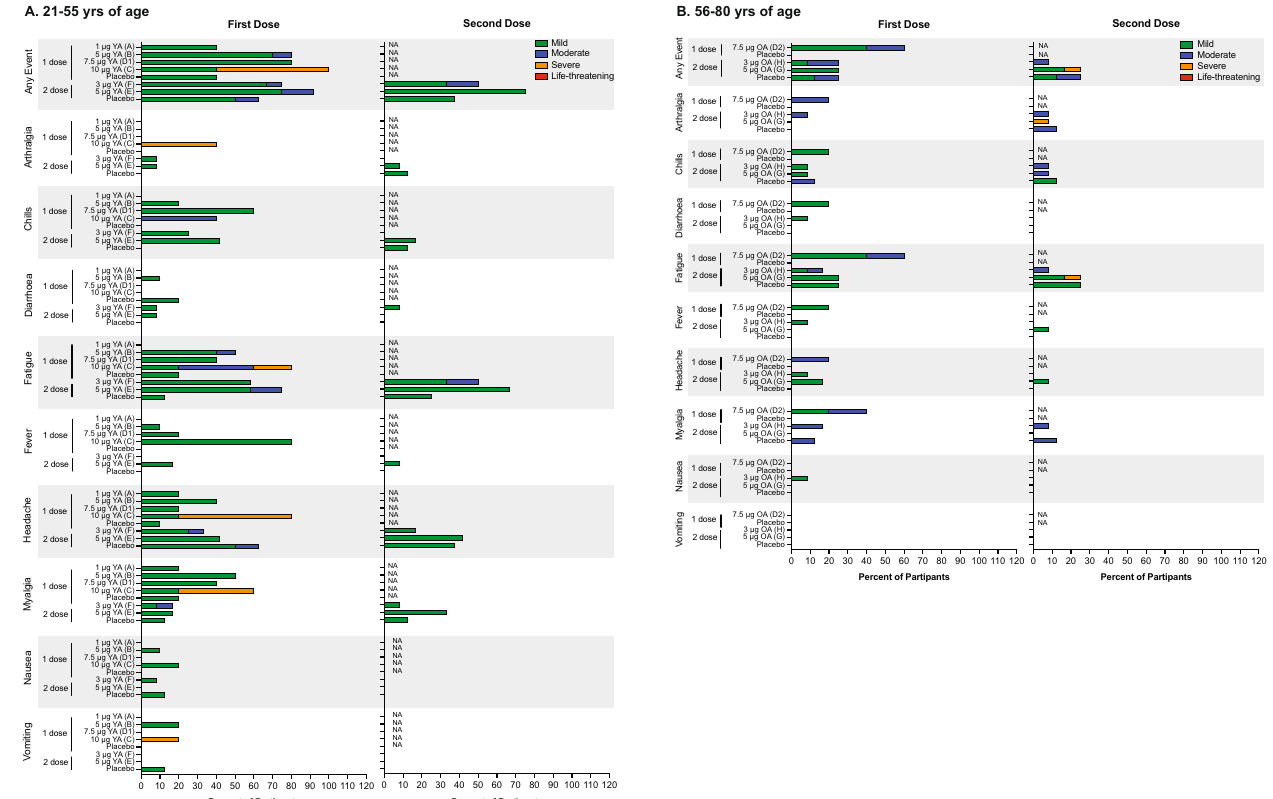
Fig. 3 Systemic solicited adverse events. Percentage of systemic solicited events reported in vaccinated participants aged 21 – 55 years ( A ) and 56 – 80 years ( B ). Severity of systemic solicited Events are displayed as mild (green), moderate (blue), severe (orange), or life-threatening (red). YA younger adults (21 – 55), OA older adults (56 –